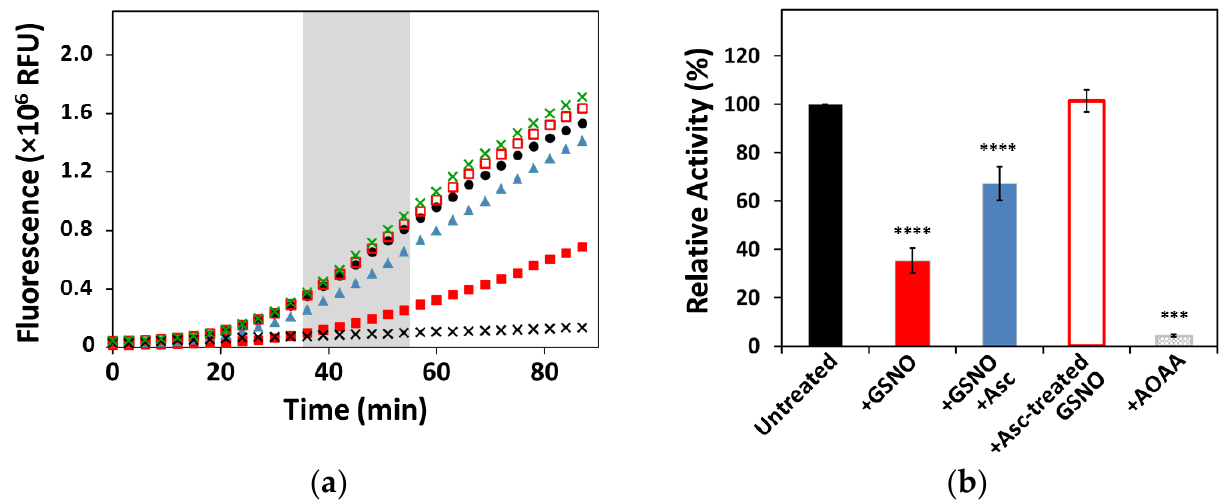
Figure 1. Effect of GSNO on CSE enzymatic activity. H 2 S production by CSE was measured at 37 ◦ C, monitoring AzMc fluorescence in a plate reader. Reaction mixtures contained CSE (80. µ g · mL − 1 ) in 200 mM Tris-HCl pH 8.0, 50 µ M PLP, 2.5 mM L -cysteine, and 2.5 mM L -homocysteine. CSE activity was analyzed for the as isolated protein (black circles; Ctrl) and for CSE incubated with: GSNO (red full squares; +GSNO); GSNO and subsequently ascorbate (blue triangles; +GSNO +Asc); GSNO preincubated with ascorbate (red hollow squares; +Asc-treated GSNO); ascorbate alone (green × ); and AOAA (black × ). ( a ) Representative reaction traces, highlighting the region of the curve where CSE activity was measured from the calculated slope (grey bar). ( b ) Histogram representing relative activities normalized to unreacted CSE. Error bars represent the standard error (SE), where n ≥ 3. Differences between groups were assessed by one-way ANOVA, **** p < 0.0001, *** p < 0.001.